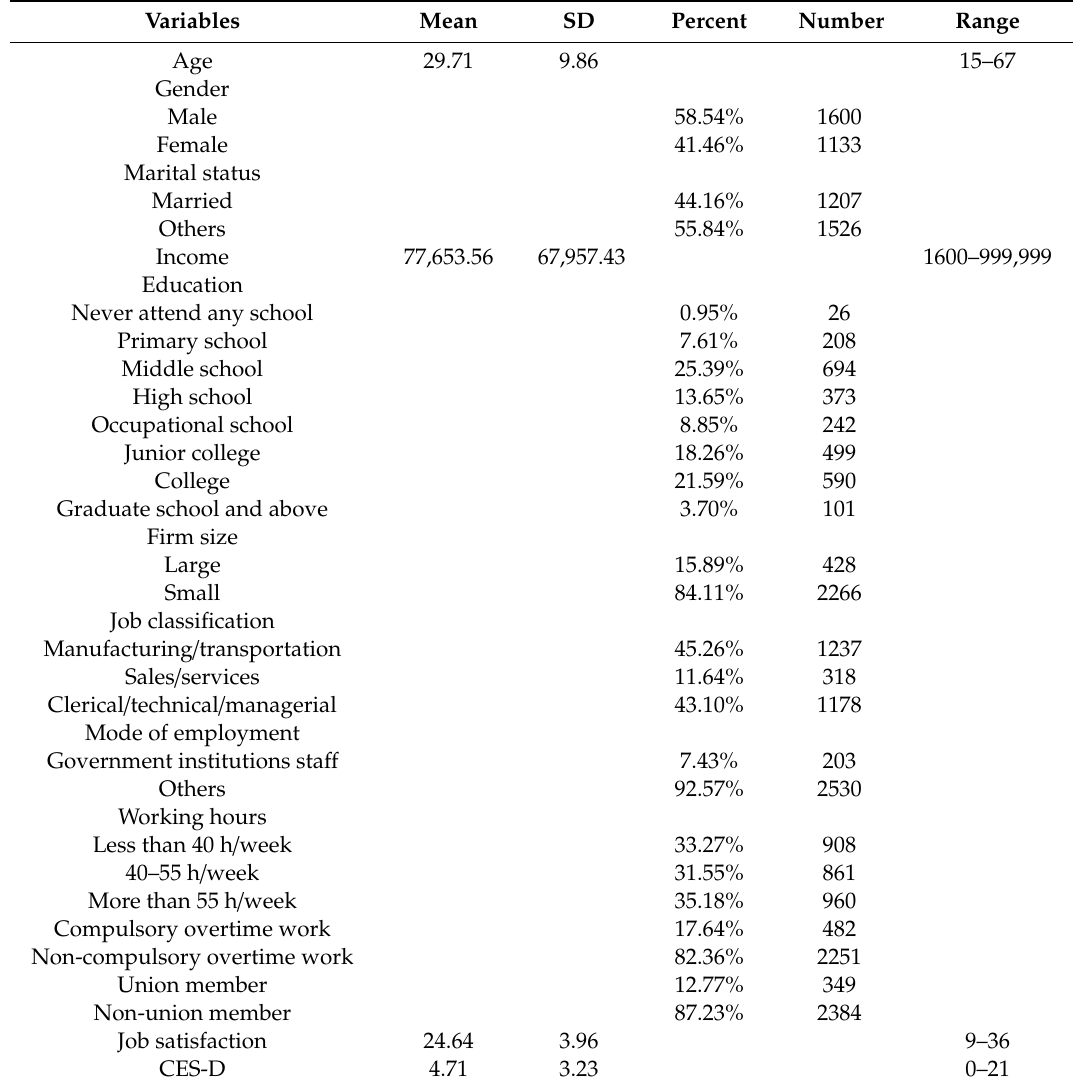
Table 1. Descriptive statistics ( N = 2733).